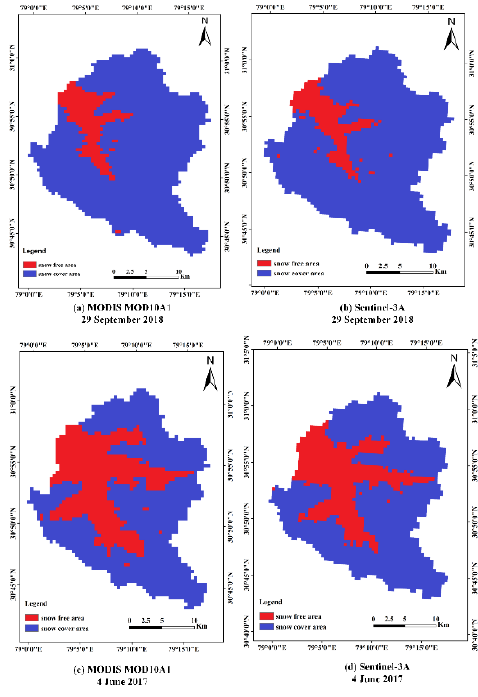
Figure 6. Comparison of Snow Cover Maps between Sentinel- 3A and MODIS MOD10A1 product for same